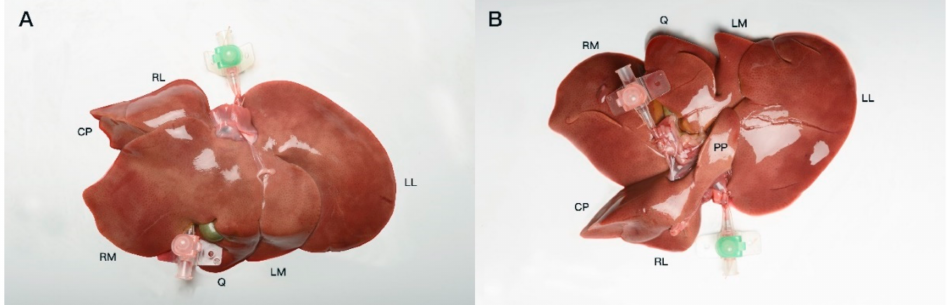
Figure 1. Visceral view of a feline liver prior to casting with both PV (pink catheter, caudal) and post-hepatic catheterized CdVC (green catheter, cranial) ( A ). Diaphragmatic view of the same liver ( B ). CP, caudate process caudate lobe; RM, right medial; Q, quadrate; LM, left medial; LL, left lateral; PP, papillary process caudate lobe.